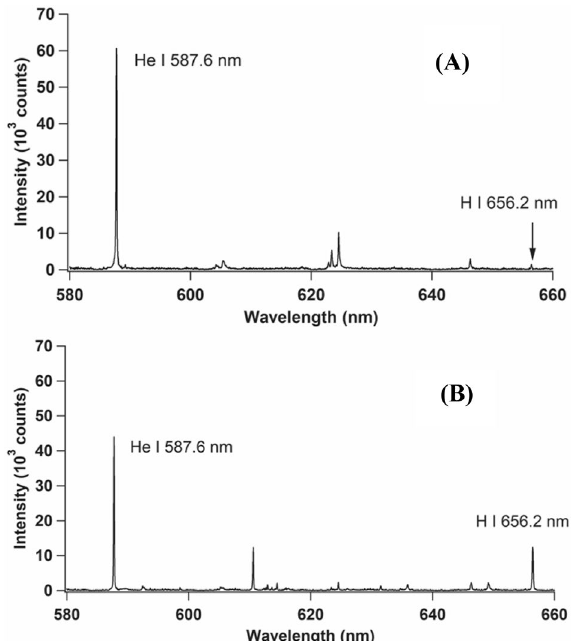
Figure 5. Emission spectra of zircaloy-4 sample containing 800 mg/kg of H. ( A ) Only the first laser was turned on with the same energy of 82 mJ in He gas at 3 kPa. The gate delay and gate width of the detection system were set as 200 ns and 50 μs, respectively, after the initiation of the first laser. ( B ) Both lasers were turned on as per the conditions mentioned in Fig. 4. The Echelle spectrograph of Andor M500 was used to obtain the wide wavelength range. The Al sub-target was used in this